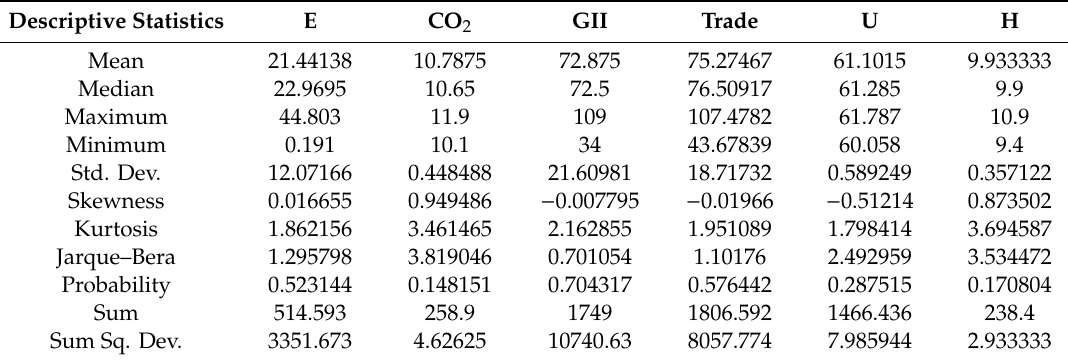
Table 5. Descriptive statistics for E, CO 2 , GII, Trade, U and H for Poland,